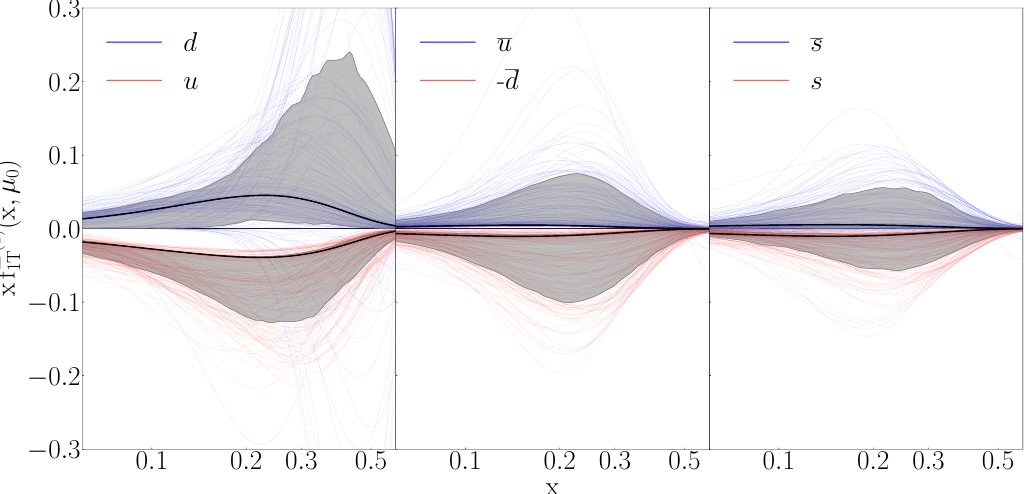
Figure 15 . The extracted transverse moment of the Sivers function from fit 2b in table 1 at √ µ 0 = 1 . 9 GeV. The black curve is the fit to the experimental data with no Gaussian